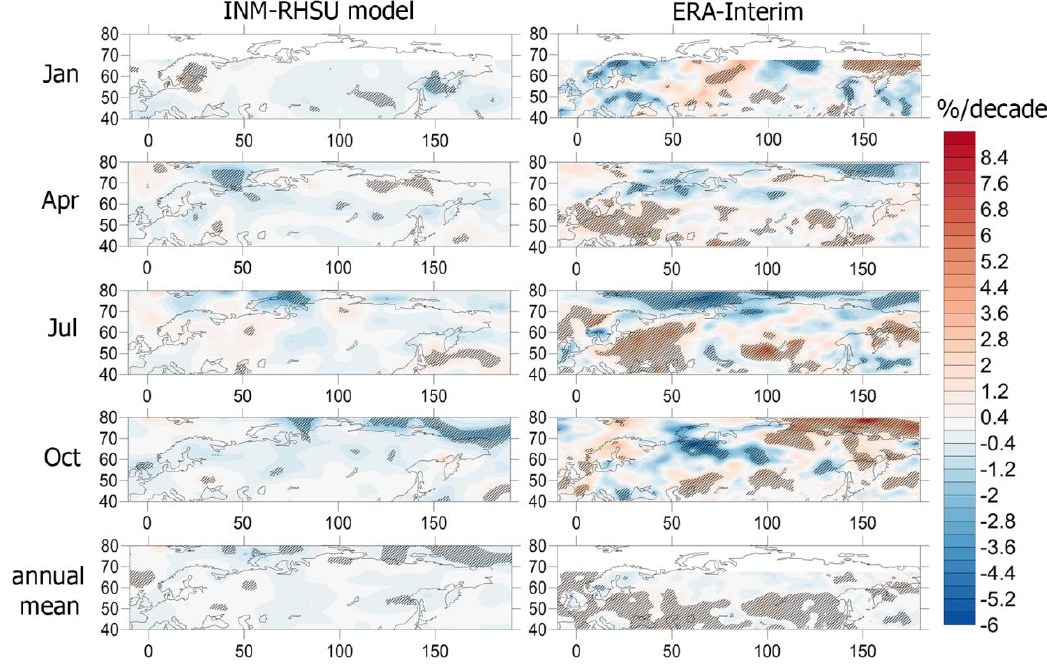
Figure 11. The decadal trends in Eery due to changes in cloudiness according to the INM-RSHU CCM simulations and the retrievals from the ERA-Interim dataset over the 1979–2015 period. Statistically significant trends at 95% level are shown by hatching. X-axis—is longitude, Y-axis—is latitude.